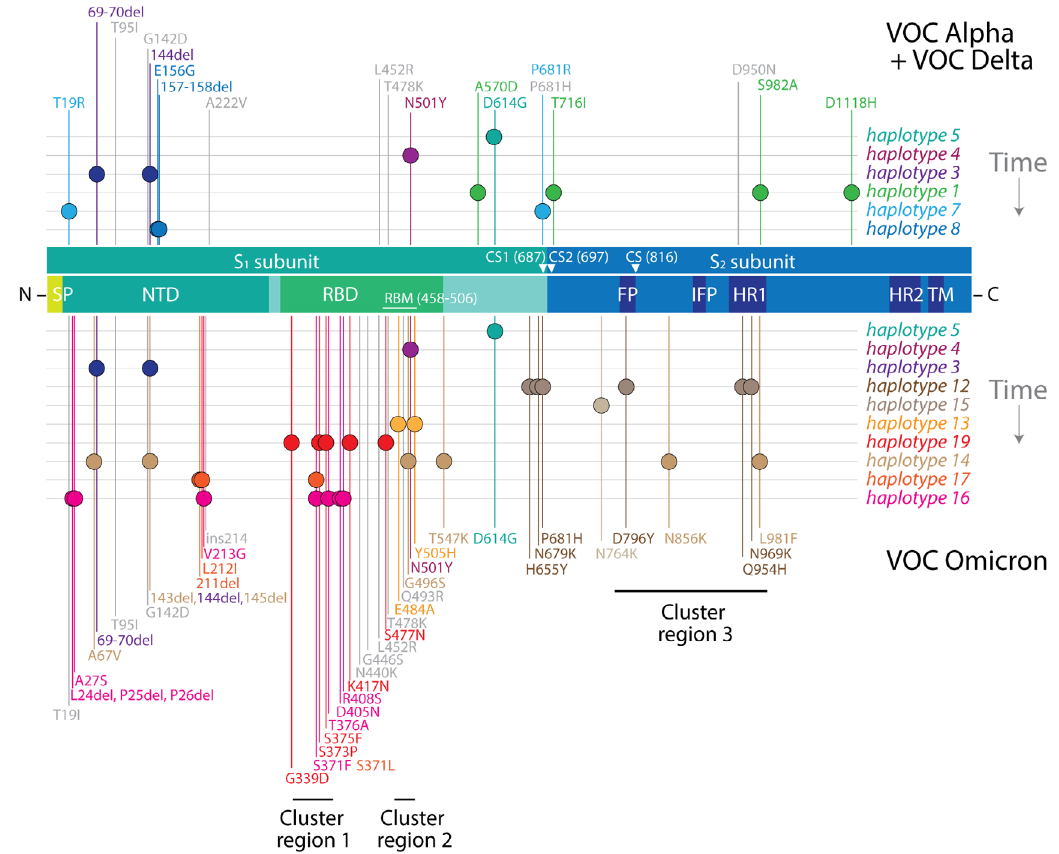
Figure 8. Haplotype markers clustered along the S-protein sequence. The diagram maps mutations onto the amino acid sequence of the S-protein molecule, from the N- to the C-terminus, with markers specific to VOCs Alpha and Deltaindicated atthe topand thosespecific toVOC Omicron atthe bottom.Mutationsin VOC Omicron cluster in groups according to haplotype and are enriched in immune evasion functions associated with the RBD region. Mutations in haplotypes 1, 12, and 14 spread through the molecule and likely make up networks of allosteric interactions. Clusters 1, 2, and 3 represent mutation targets at codon sites known to be either negatively selected or evolving under no detectable selection in non-Omicron sequences (Martin et al. , 2022). Markers highlighted in grey represent free-standing mutations. SP, signal peptide; NTD, N-terminal domain; RBD, receptor-binding domain; RBM,receptor-binding motif;CS,cleavagesite; FP,fusionpeptide; IFP,internalfusionpeptide; HR1,heptadrepeat1; HR2, heptad repeat 2; TM, transmembrane differs from the reference strain by one mutation, I82T of haplotype 7. Conversely, VOC Omicron differs from the reference strain by four mutations: D3G of haplotype 14 , Q19E and A63T of haplotype 15 , and D3N of haplotype 22 ’ . D3G and D3N are located in an intrinsically disordered region of the molecule (Zhang et al. , 2022b). All mutations were located in the N-terminal region of the molecule, but most structural effects were felt downstream in the C-terminal β -sheet domain region.